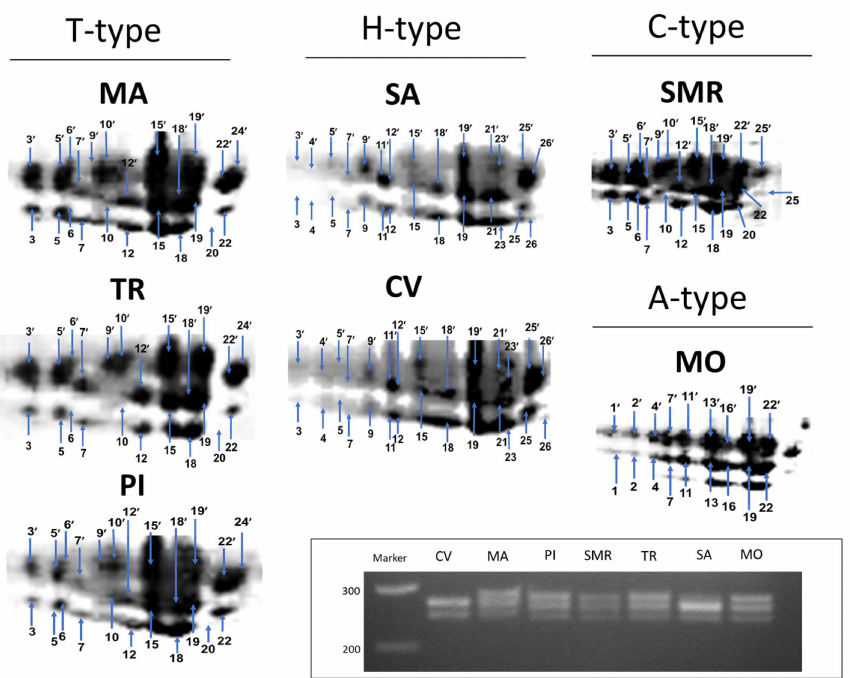
Figure 2. Phaseolin patterns. The 2-DE phaseolin spot patterns of seven common bean populations. Spots were numbered after comparison using the 2-DE maps reported in De la Fuente et al. [44]. Spots of different Mr and similar pI were denoted with and without apostrophes, respectively. The 2-DE imaging was performed using 50 µ g of total protein loaded on Bio-Rad 7 cm long IPG strips containing pH 4–7 and 12% polyacrylamide gel. The amplification by PCR of the SCAR marker of the phaseolin in the seven common bean populations is shown in the rectangle. The ladder range is 200–300 base pairs (ApplyChem GmbH, Darmstadt, Germany). CV: Ciliegino; SMR: San Michele Rosso; MO: Monachella; MA: Mascherino; PI: Pinto; TR: Tuvagliedda Rossa; SA: Suocera e Nuora. C: Contender; T: Tendergreen; H: Huevo de Huanchaco; A: